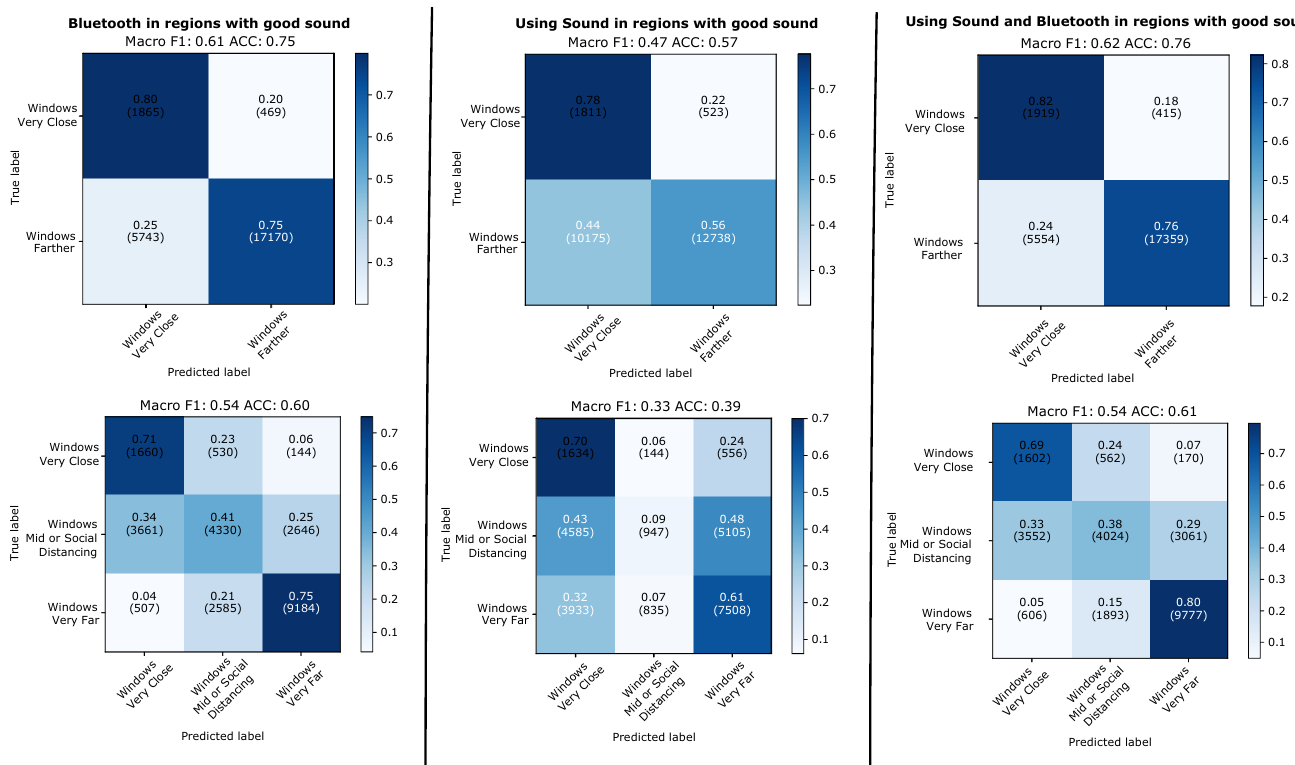
Figure 11. Leaving-one-day-out. Results predicting individual 5 s windows with good